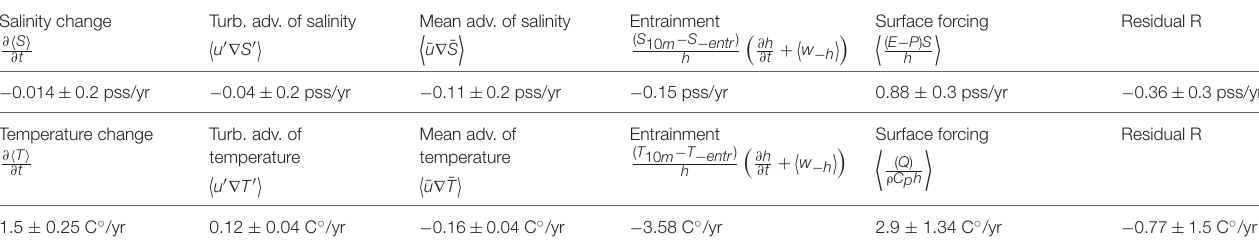
TABLE 1 | Annual averaged means of the components in Equations (1) and